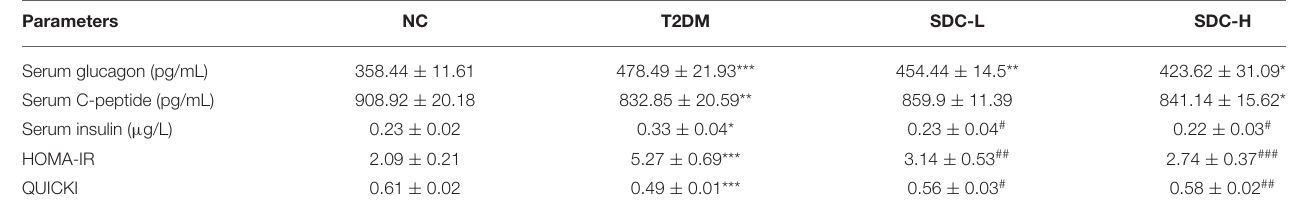
TABLE 3 | Effect of SDC on glucagon, C-peptide, insulin, HOMA-IR, and QUICKI.